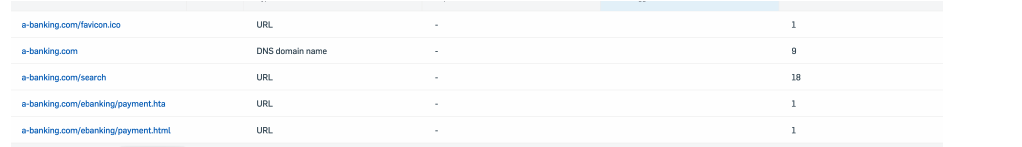
Figure 22. Network connections to our domain as logged by